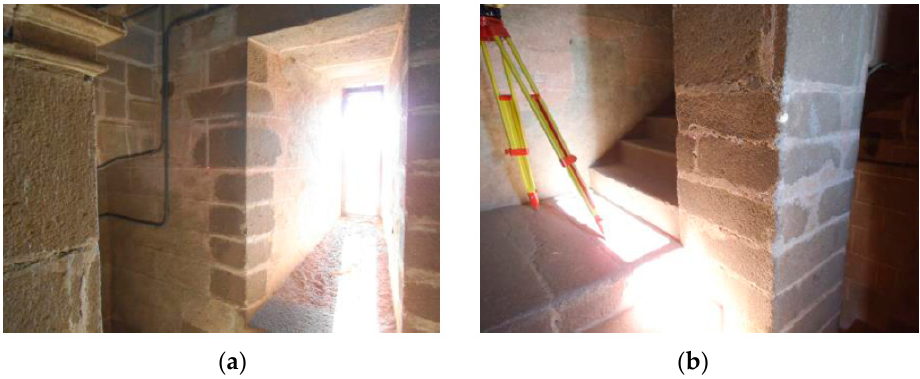
Figure 10. Walls built with granite ashlars ( a , b ). Interior of Santa María Church, Guareña (Spain).